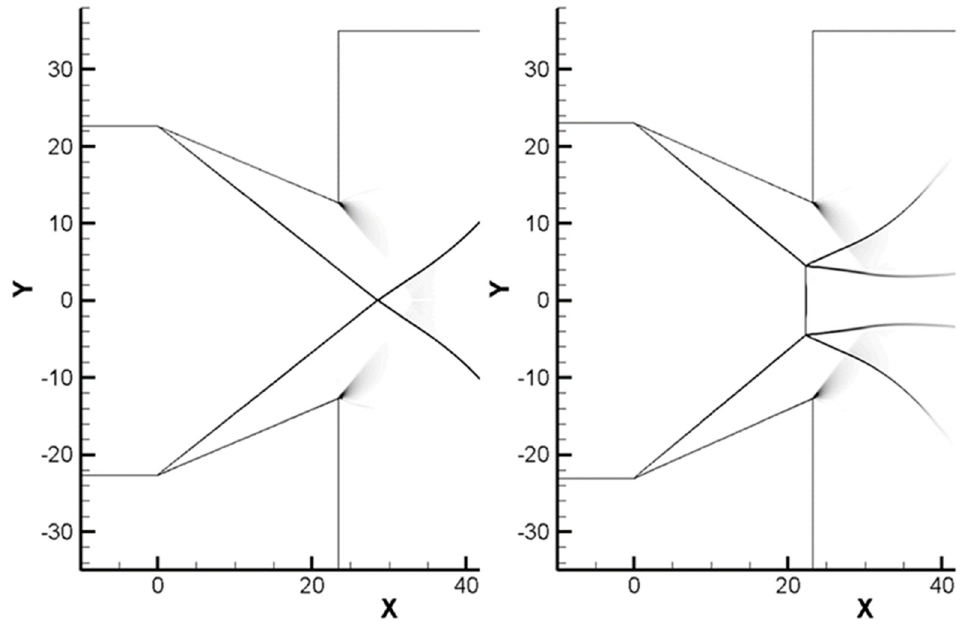
◦ wedge), Mach reflection ( right , 24 ◦ Figure 5. Regular reflection ( left , 23° wedge), Mach reflection ( right , 24° wedge). Figure 5. Regular reflection ( left , 23